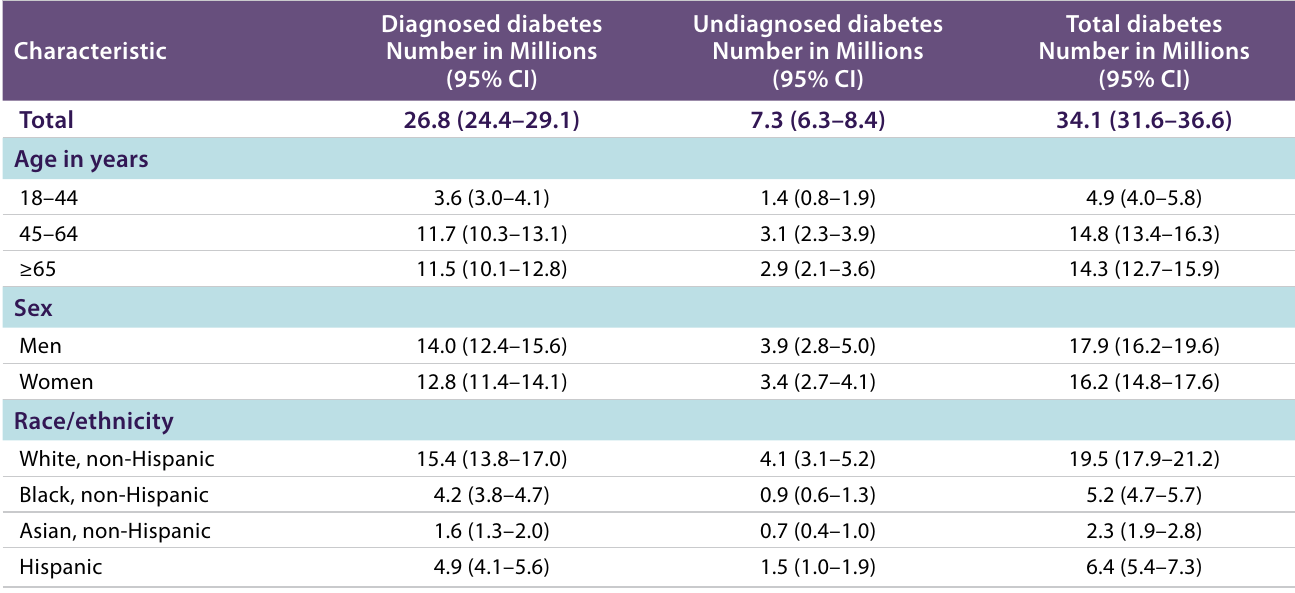
Table 1b. Estimated number of adults aged 18 years or older with diagnosed diabetes, undiagnosed diabetes, and total diabetes, United States, 2018